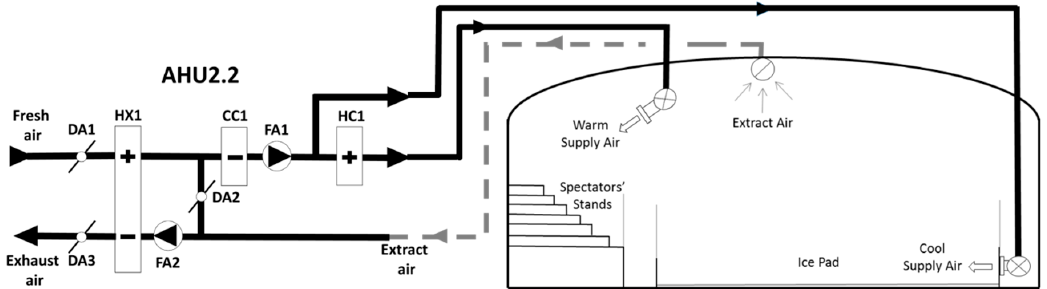
Figure 6. Schematic view of AHU2.2 and its corresponding air distribution system.